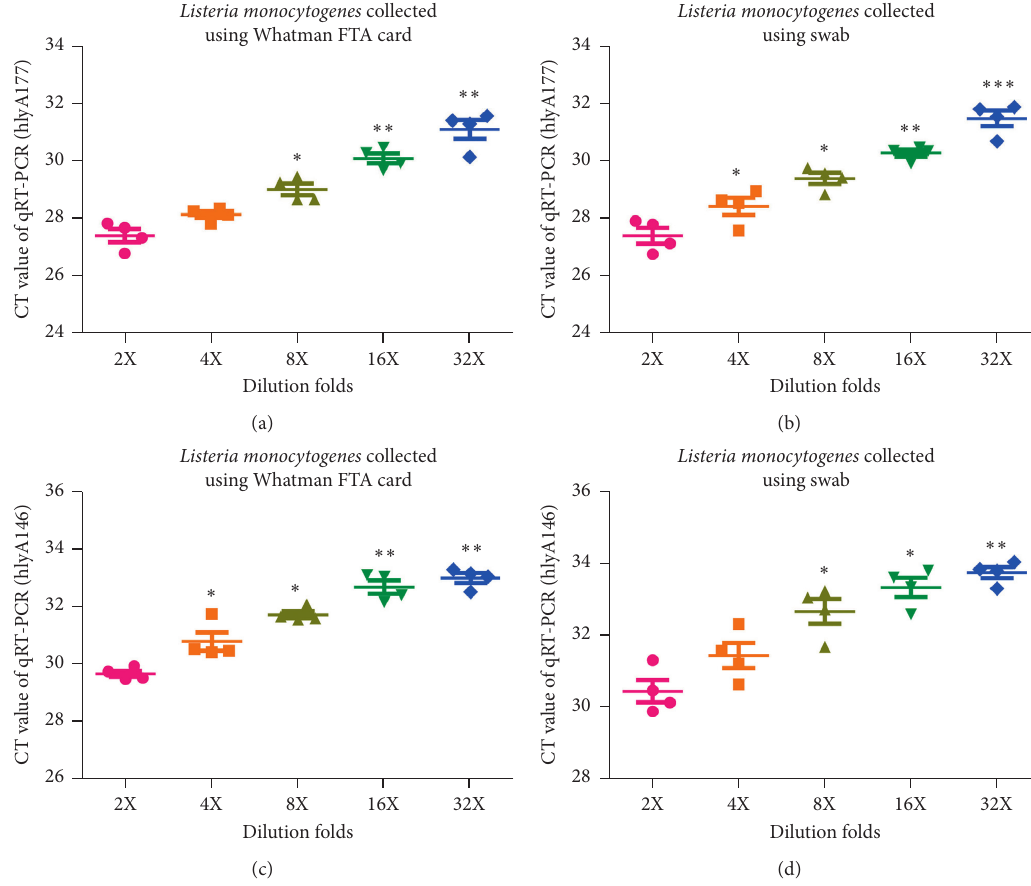
Figure 4: CTvalues of Listeria monocytogenes genes in samples on Whatman FTA Elute cards are higher than those on swabs. (a) Expression level of the hly177 gene in a serially diluted laboratory strain of Listeria monocytogenes samples on Whatman FTA cards detected by RT- qPCR ( n � 6, ∗ P < 0 . 05 and ∗∗ P < 0 . 01). (b) Expression level of the hly177 gene in a serially diluted laboratory strain of Listeria mono- cytogenes samples on swabs detected by RT-qPCR ( n � 6, ∗ P < 0 . 05 and ∗∗ P < 0 . 01). (c) Expression level of the hly146 gene in a serially diluted laboratory strain of Listeria monocytogenes samples on Whatman FTA cards detected by RT-qPCR ( n � 6, ∗ P < 0 . 05, ∗∗ P < 0 . 01, and ∗∗∗ P < 0 . 001). (d) Expression level of the hly146 gene in a serially diluted laboratory strain of Listeria monocytogenes samples on swabs detected by RT-qPCR ( n � 6, ∗ P < 0 . 05, ∗∗ P < 0 . 01, and ∗∗∗ P < 0 . 001). RT-qPCR: reverse transcription-quantitative PCR; FTA: Flinders Technology